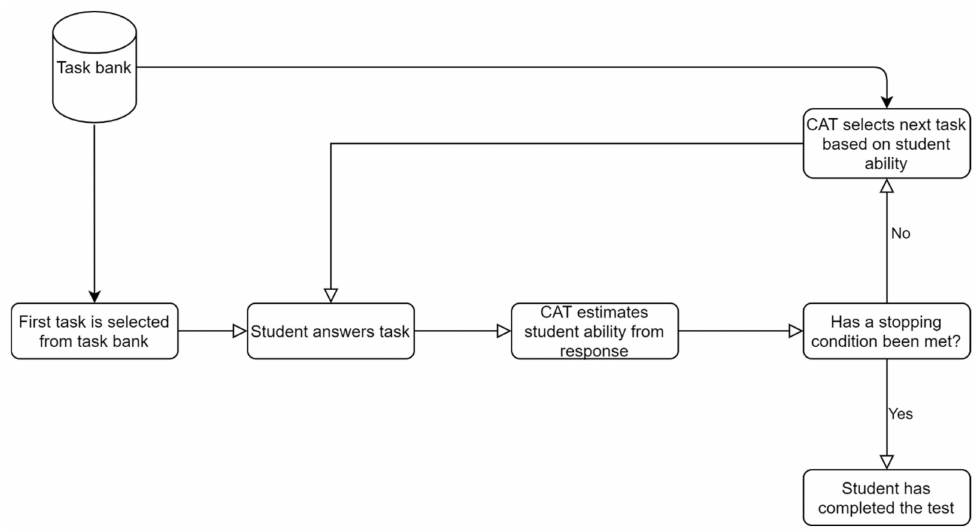
Figure 1. The procedure of computerized adaptive testing